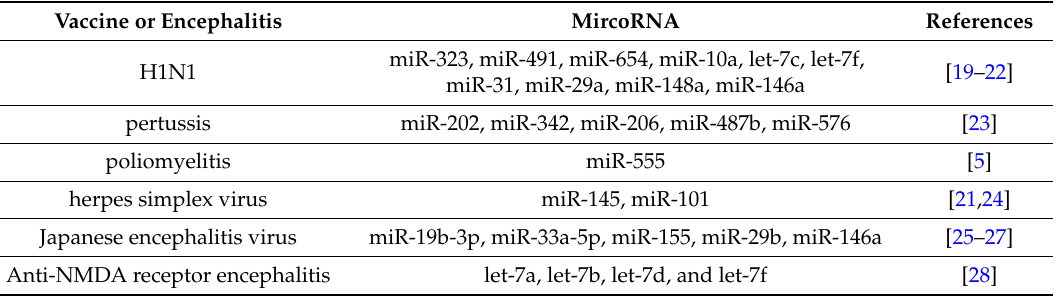
Table 1. miRNAs related to vaccination or encephalitis.